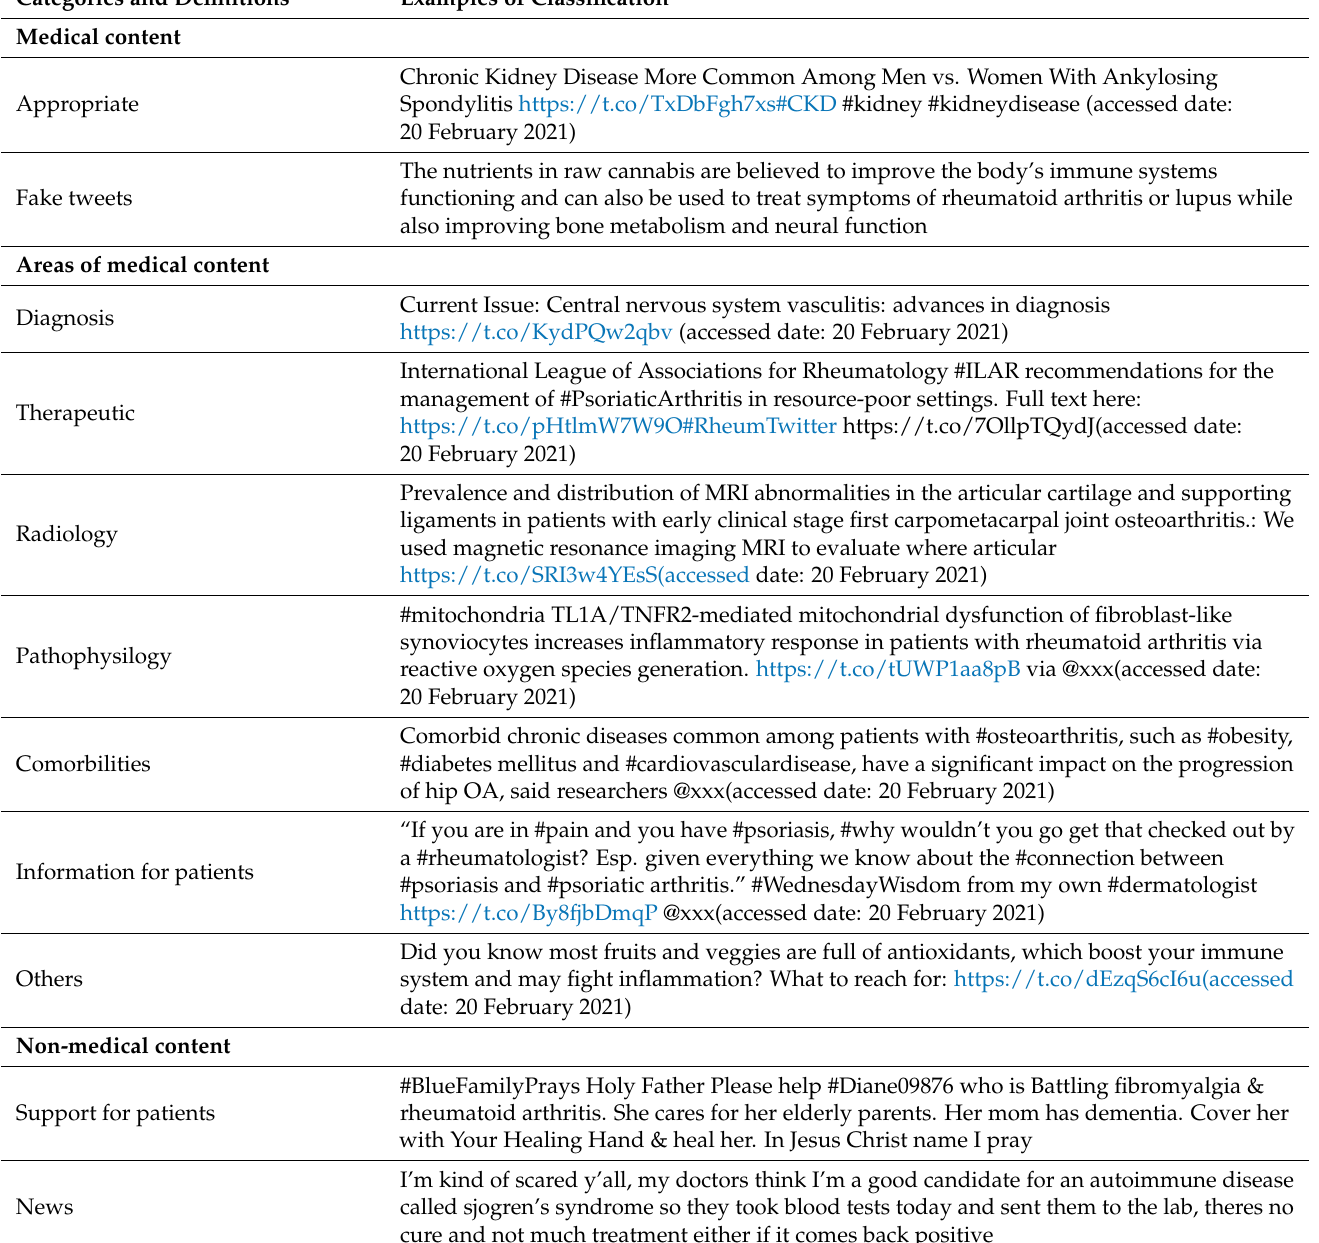
Table A1. Examples of tweets by